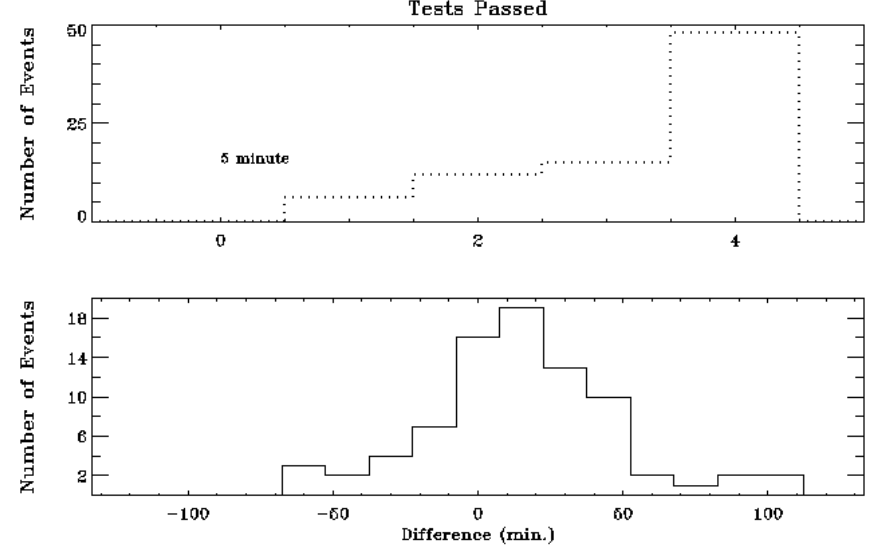
Fig. 9. Histograms considering the N =81 WIND MC set (Data Set #3) for the period early 1995 to August 2003, for the 5-min tests only. (Top) Histogram showing the number of MC events that passed a given number of tests, up to a maximum of four tests with no regard to the specific nature of the test. (Bottom) Histograms giving the number of MCs that fall into time-differential buckets, where the time difference now is 1t 1 =[ t B *– t B